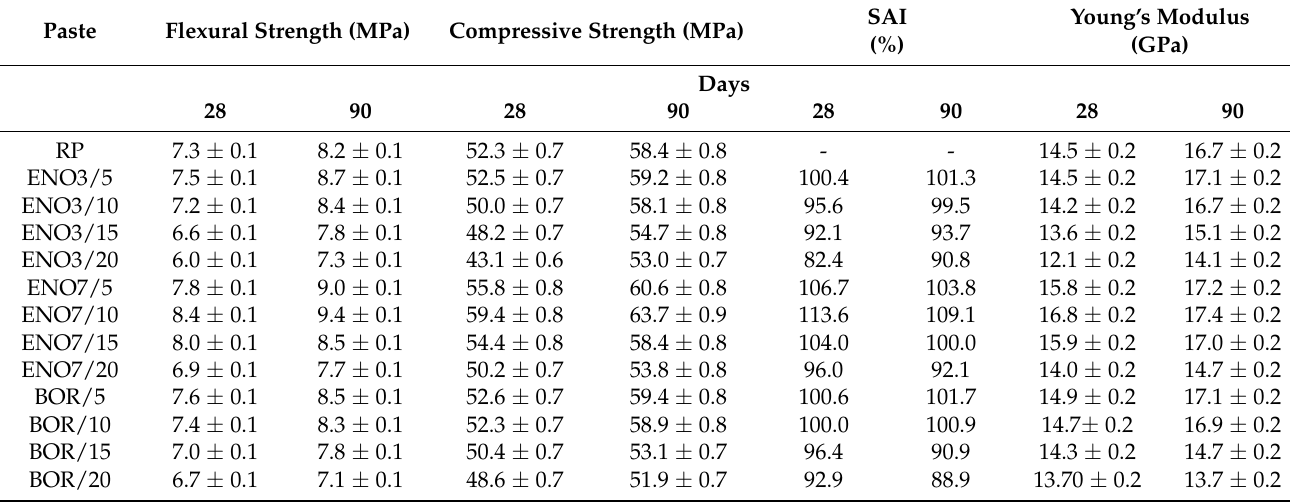
Table 13. Mechanical parameters of hardened